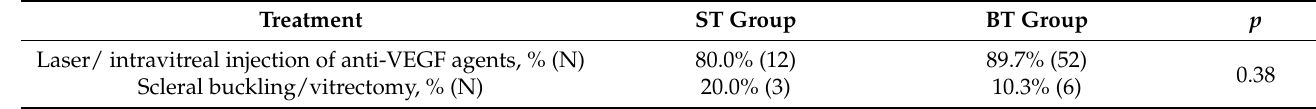
Table 4. Treatments of infants grouped according to whether both twins received